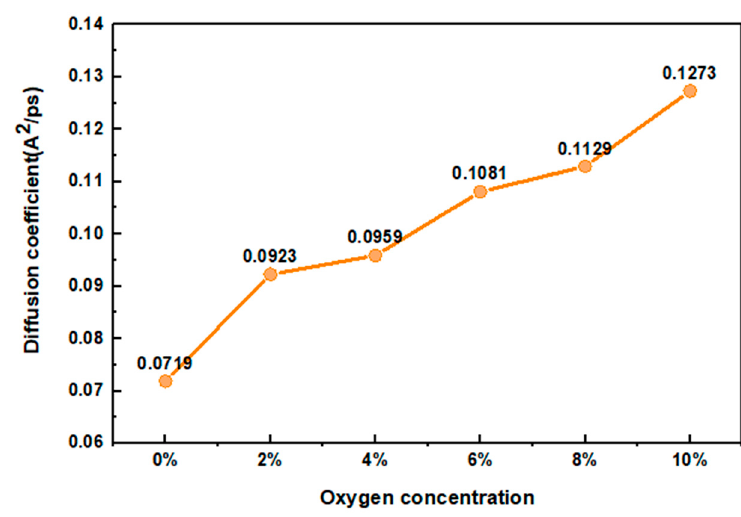
Figure 3. Diffusion coefficient of water